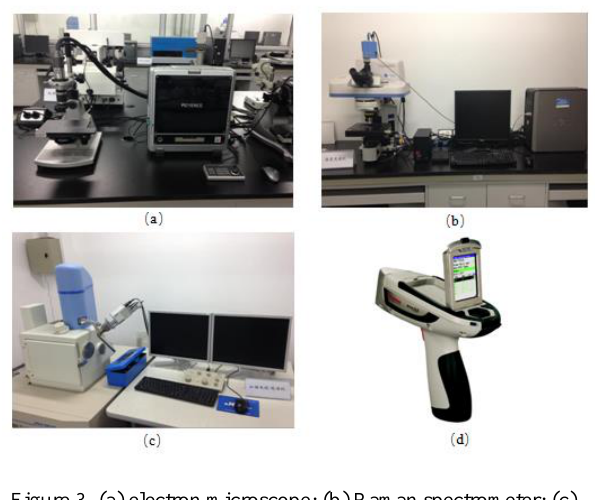
Figure 3. (a) electron microscope; (b) Raman spectrometer; (c) scanning electron microscope; and (d) portable